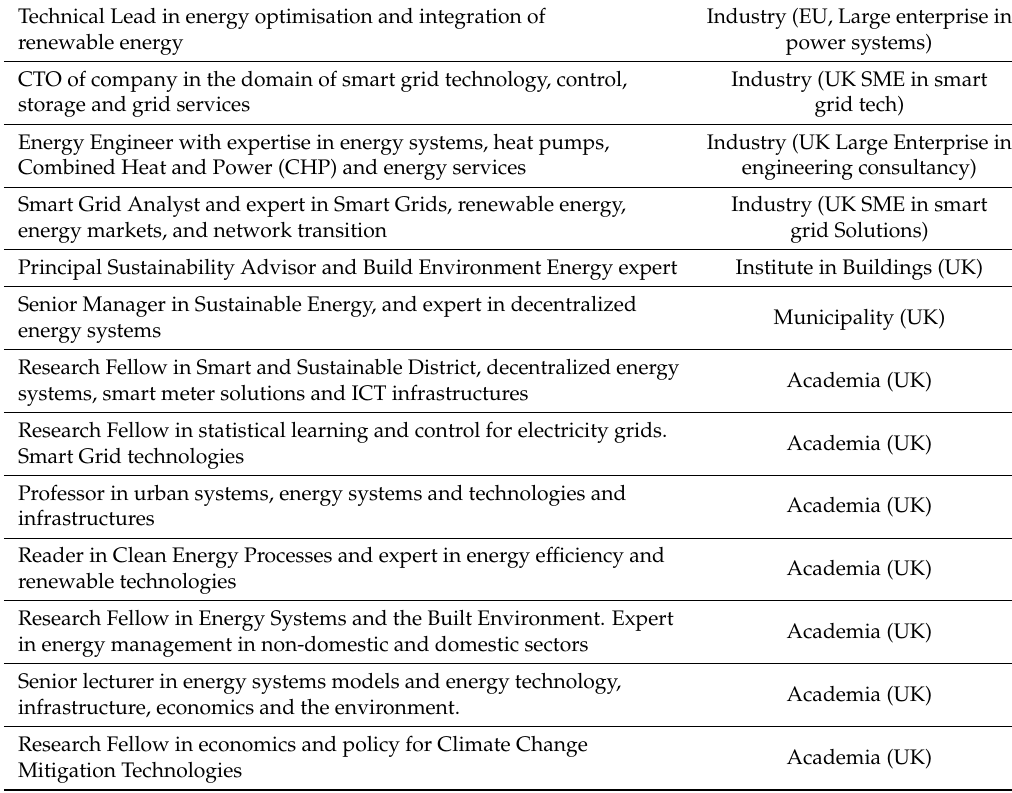
Table 2. Overview of experts who contributed to the technology